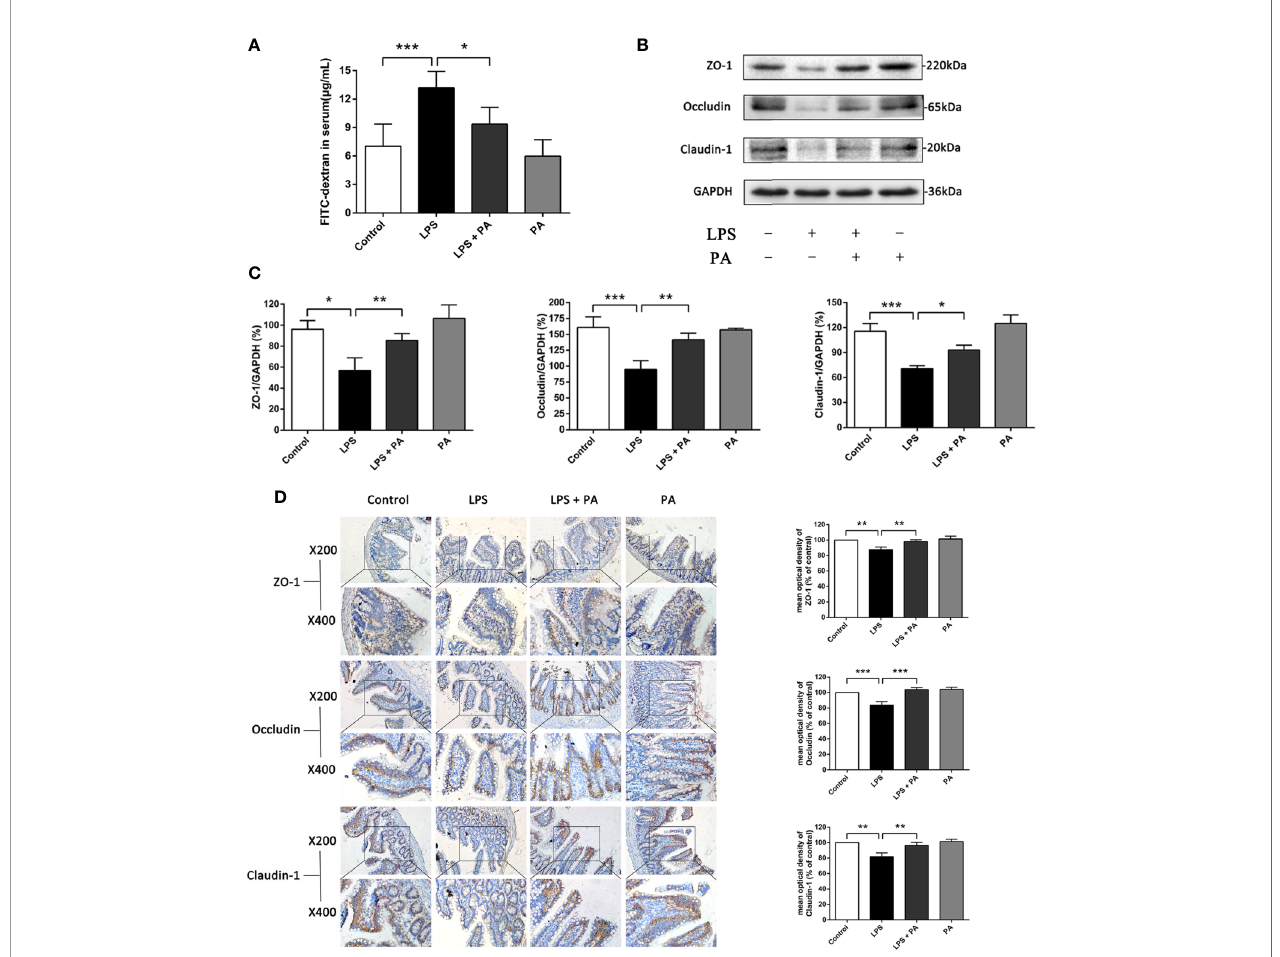
FIGURE 8 | The effects of PA on intestinal permeability and tight junction protein expression in ileal tissues. In vivo intestinal permeability and tight junction protein expression in ileal tissues were assessed at 24 h after treatment of LPS. (A) The concentration of FD10S in the serum of rats. The higher level of FD10S in the serum indicates a higher intestinal permeability, resulting from a reduced barrier function of the intestine. (B – C) The protein expressions of ZO-1, occluding, and claudin-1 were determined by western blot analysis. (D) The protein expressions of ZO-1, occluding, and claudin-1 were determined by immunohistochemistry and observed under a microscope of 200 and 400 magni fi cations. The data represent the averages ± S.D. Signi fi cant differences between the treatment and control groups are indicated as *P < 0.05, **P < 0.01, ***P < 0.001. Signi fi cance was determined by one-way